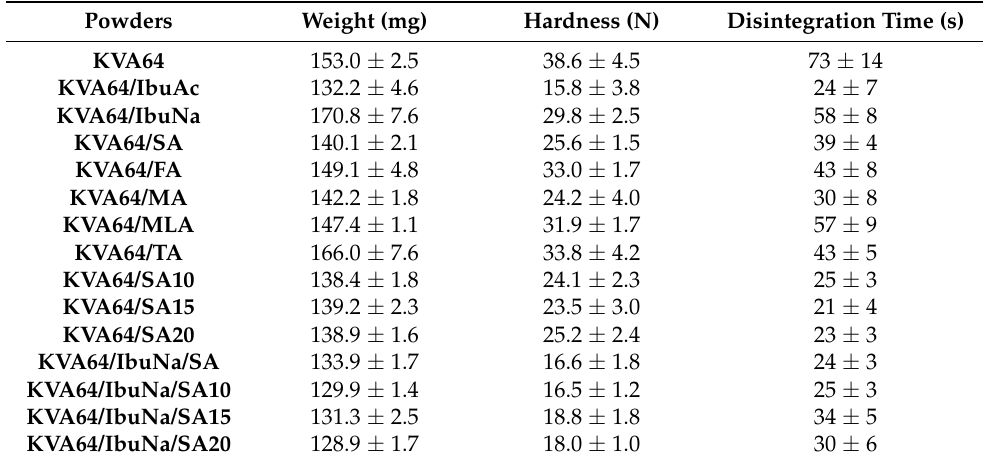
Table 4. Weight, hardness and disintegration time of the sintered